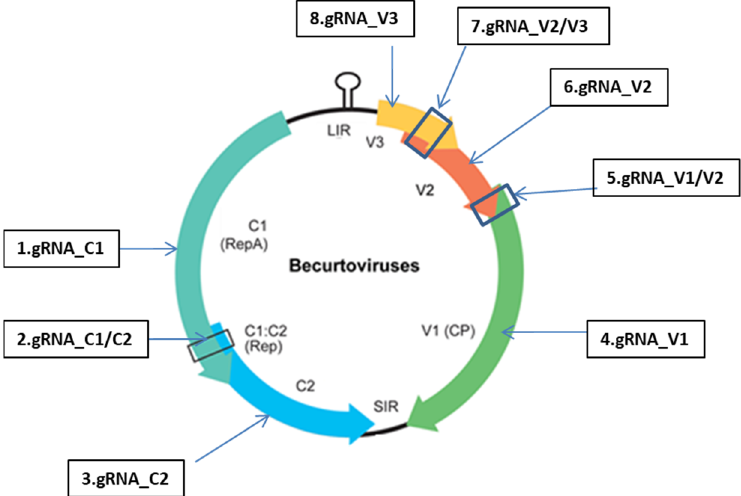
Figure 1. gRNAs targeting the genic and intergenic region of the BCTIV genome. Genic regions encoding coat protein (CP — referred to as V1), movement protein (MP — referred to as V1), ss/ds DNA regulating protein (ssDNA — referred to as V3), and Replication protein (REPA and B — referred to as C1 and C2) were targeted via CRISPR/Cas9 system with the designed gRNAs. Short intragenic region (referred to as SIR) and long intragenic region (referred to as LIR) were also represented in the figure. Detailed information about the gRNA is provided in Supplementary File S1.